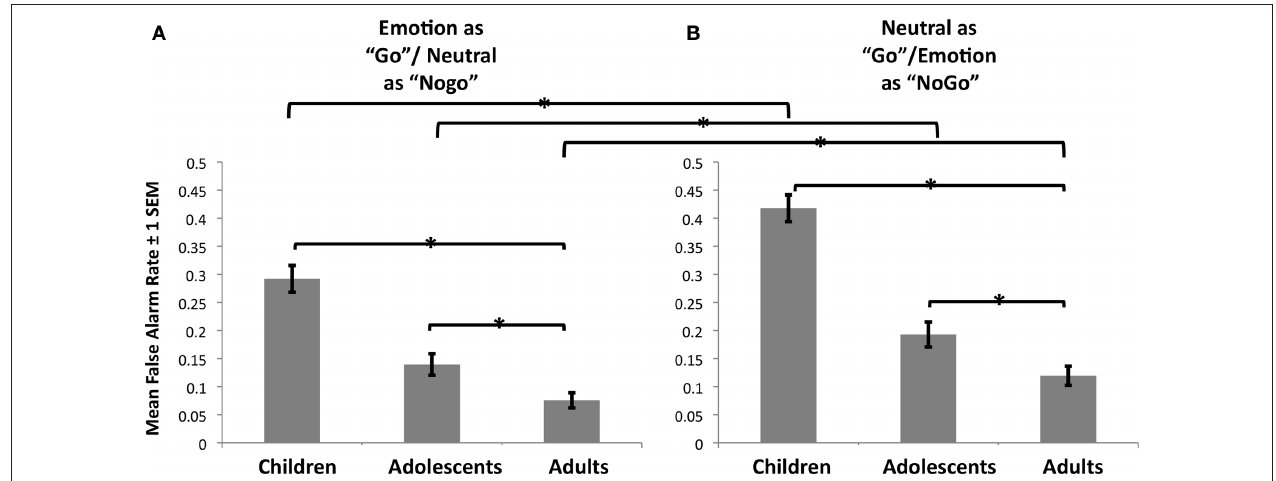
Figure 3 | Cognitive control versus emotion regulation. (A) Cognitive control showed a steady improvement in performance for each age group, as indexed by decreasing false alarm rate. (B) Relative to cognitive control, emotion regulation, defined by false alarms to emotional “nogo” stimuli, was more impaired for all subjects, and the discrepancy between cognitive control and emotion regulation diminished with increasing age